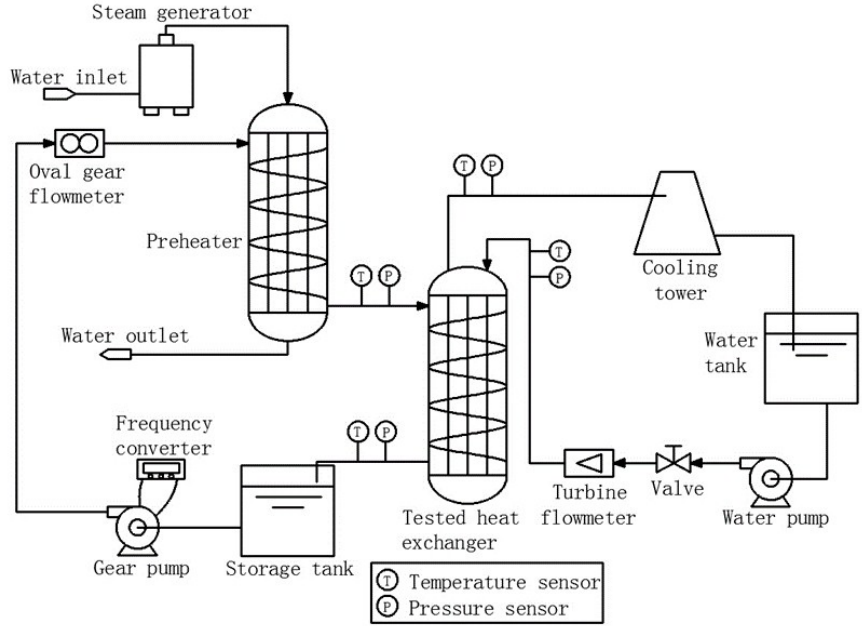
Figure 1. Schematic diagram of heat transfer experimental set ‐ up.